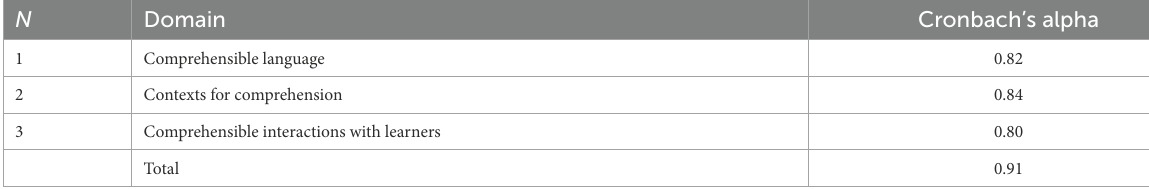
TABLE 5 Reliability coefficients for the domains and the total scale.